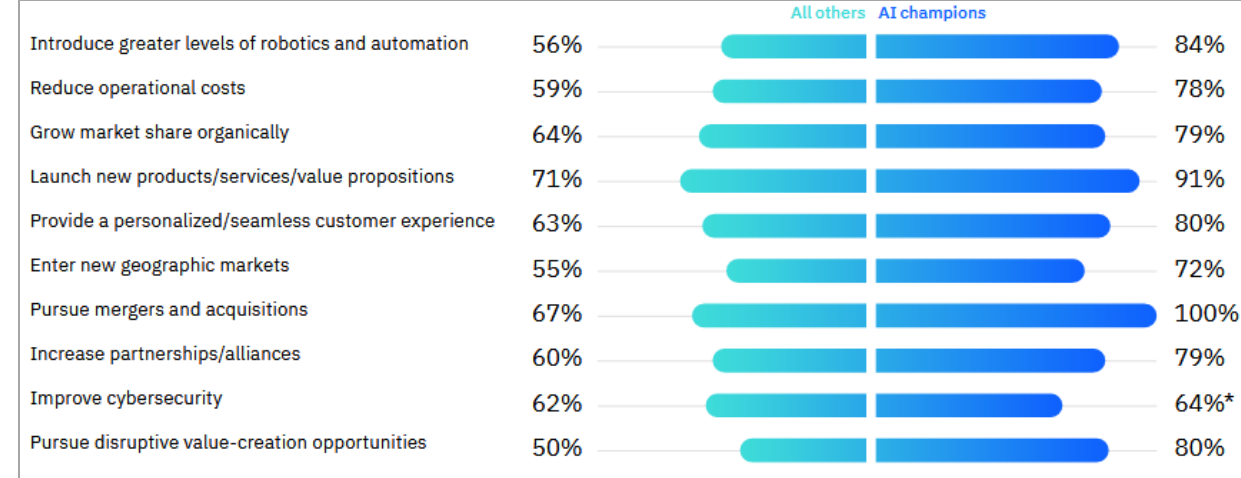
Figure 1. Levels of business objectives achieved, AI vs. traditional [3]